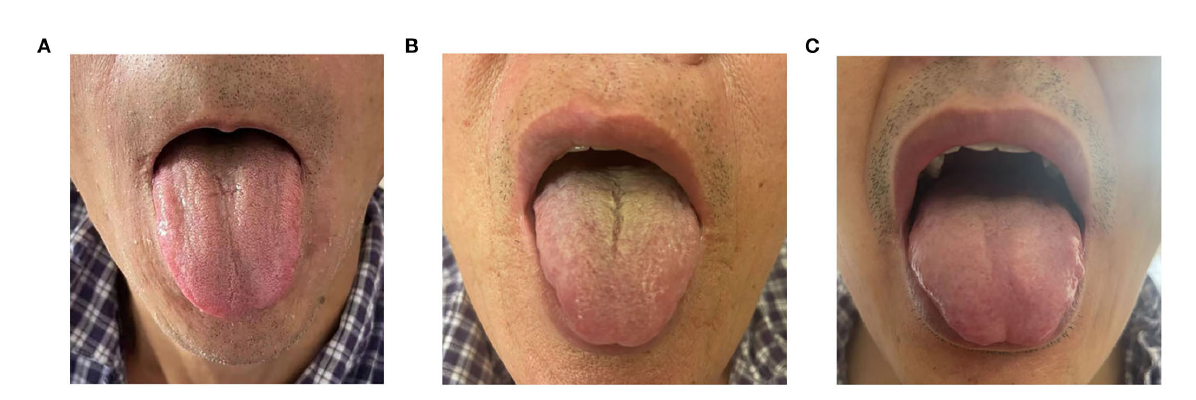
FIGURE1 Different tongue-coating images of the three groups. (A) Thick or greasy coating (LTG) group (abnormal). (B) Non-thick or greasy coating (LNTG) group (abnormal). (C) Healthy control (HC) group